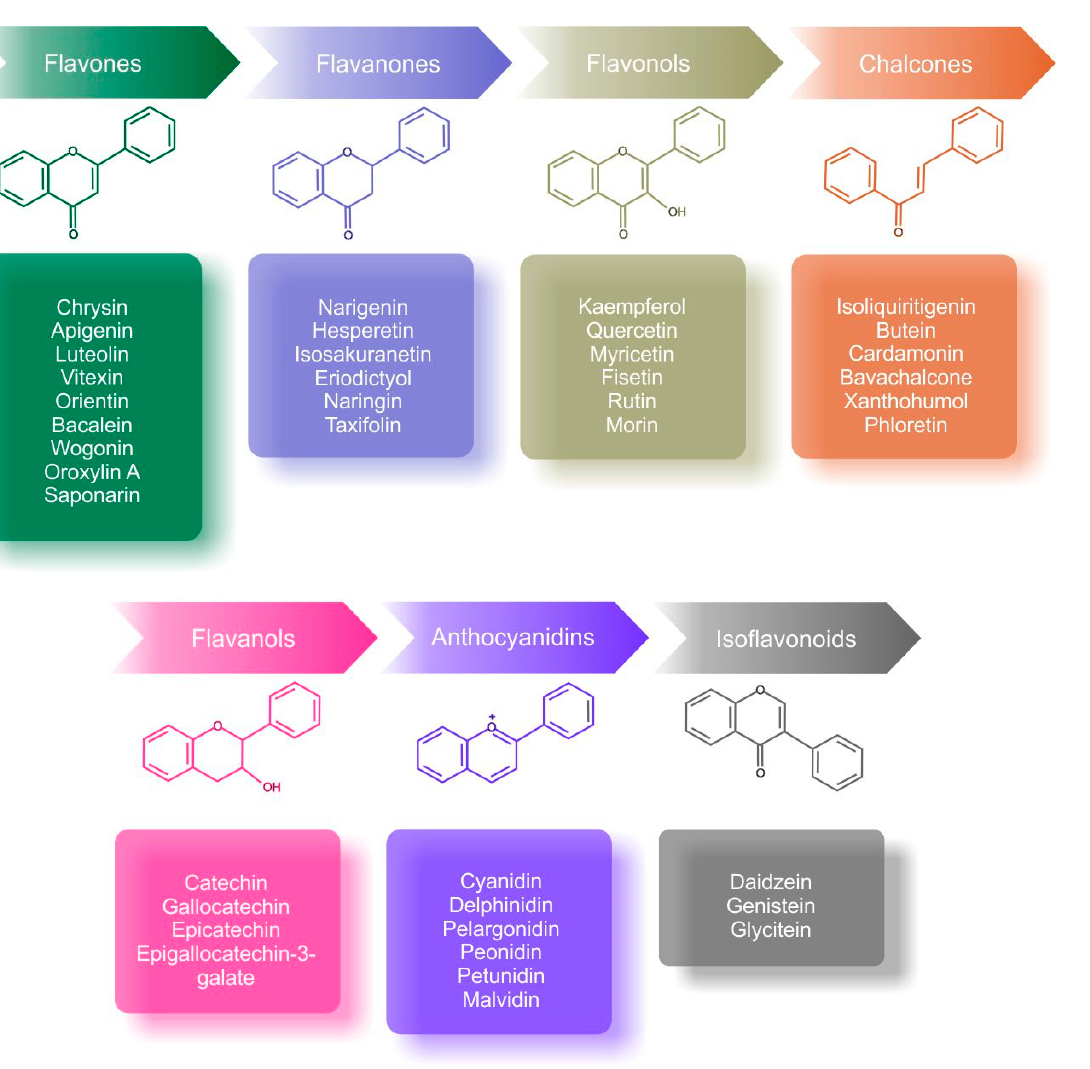
Figure 3. Classification and chemical structures of the main subgroups of flavonoids with examples